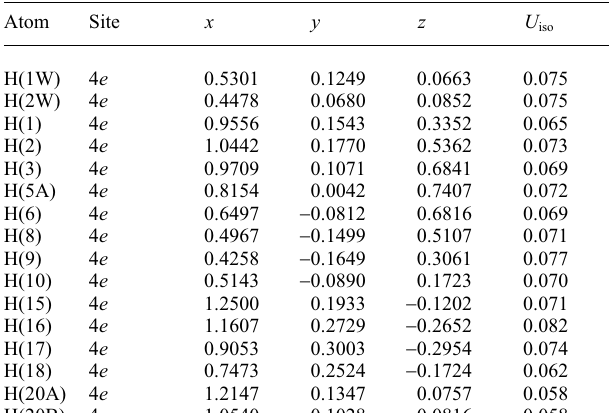
Table 2. Atomic coordinates and displacement parameters (in Å 2 ). Table 1. Data collection and